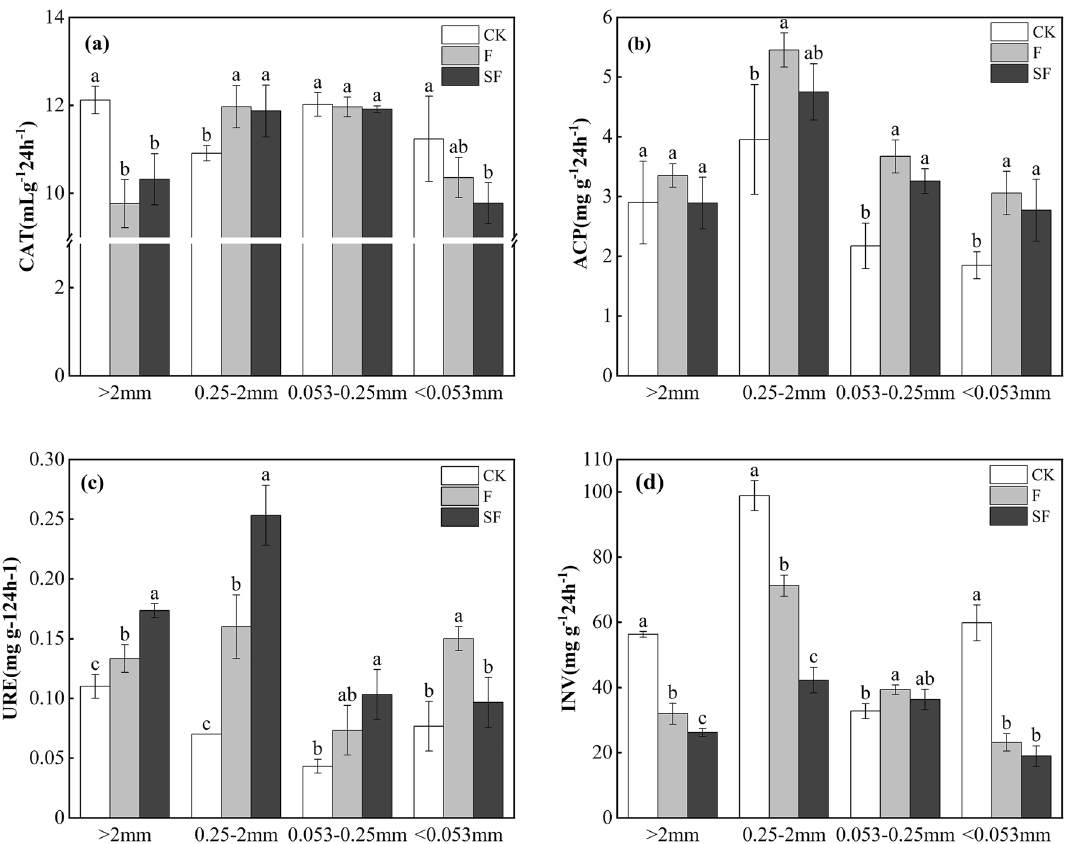
Figure 1. Enzyme activity in soil aggregates under different treatments. They are catalase (CAT), acid phosphatase (ACP), urease (URE), and invertase (INV). The error bars represent the standard errors. The letter in the figure represents the significant differences according to LSD